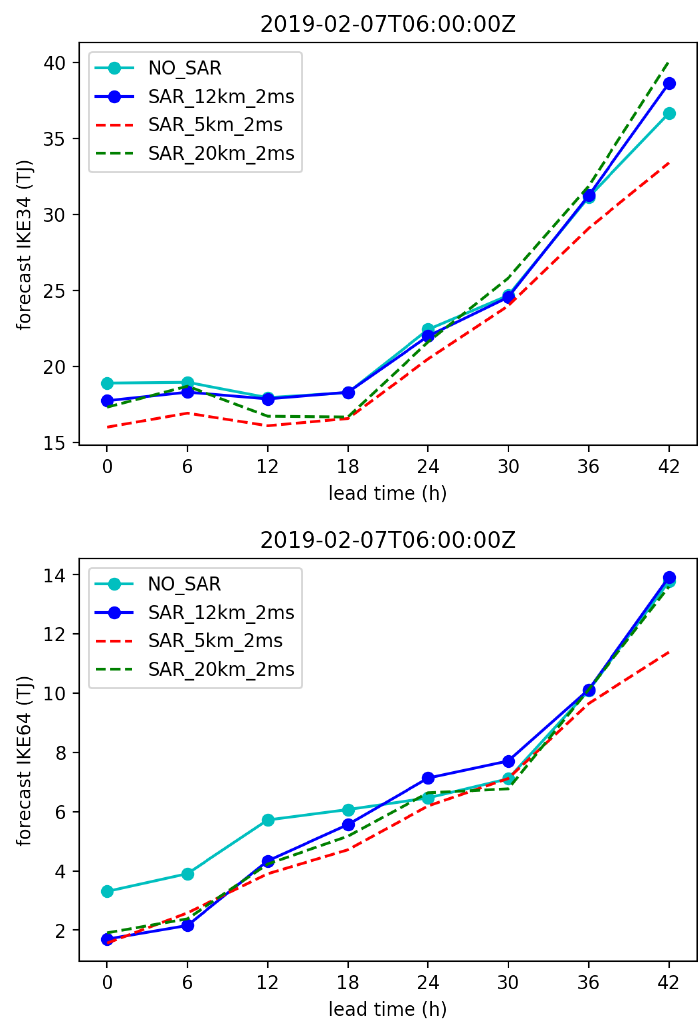
Figure 17. Evolution of IKE in the forecast of 7 February 2019 06:00Z for experiments SAR_12km_2ms and